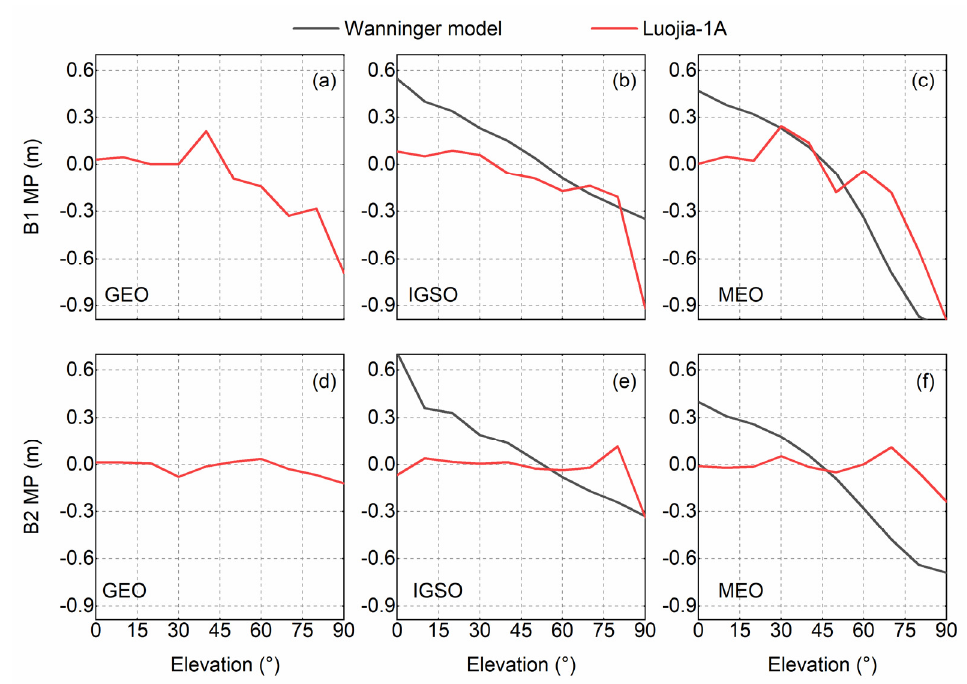
Figure 6. The elevation-dependent multipath models for the GEO, IGSO, and MEO satellites. The upper and the bottom panels represent models for B1 and B2 respectively.